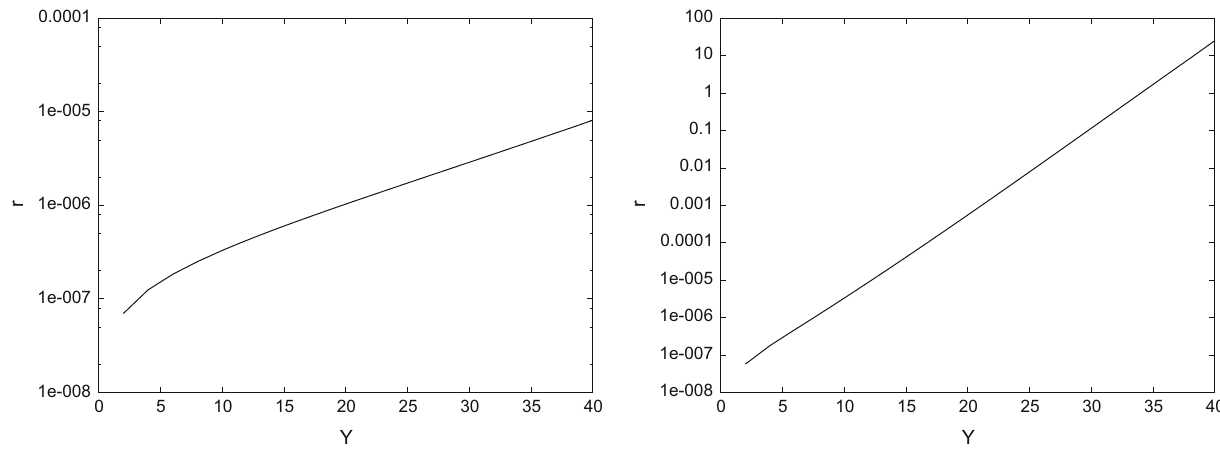
Fig. 10 The ratio of the triple pomeron part to the main one with the opposite sign with ¯ α s = 0 . 0432 (the left panel) and with ¯ α s = 0 . 2 (the right